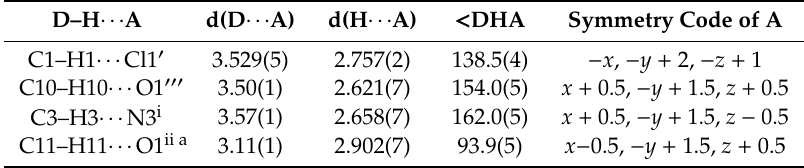
Table 3. Hydrogen bonding interactions (Å, °) in the crystal structure of [ZnCl 2 (L)] ( 1 ).